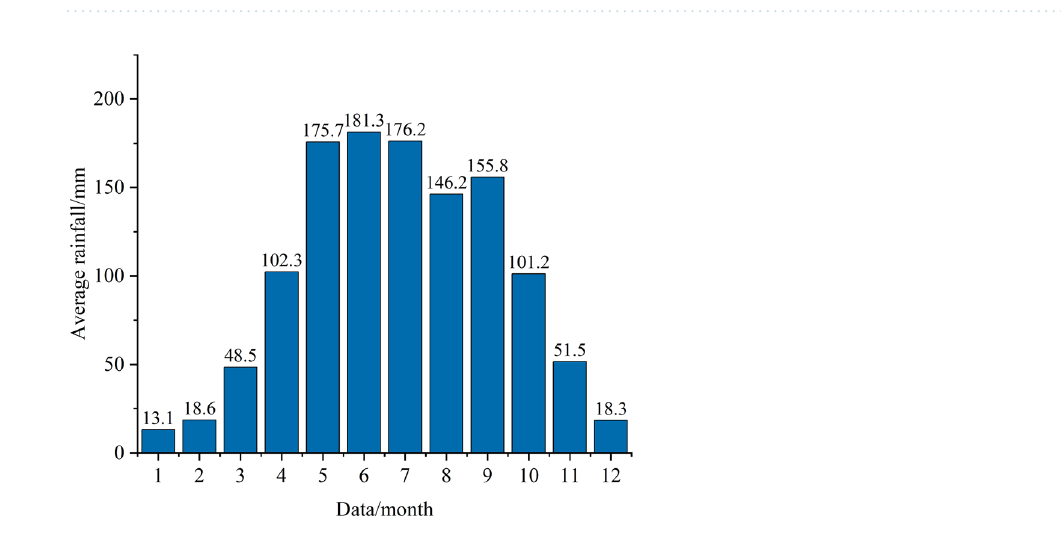
Figure 1. ( a ) Location of the study area; ( b ) location of Sifangbei landslide; ( c ) topographical map of the Sifangbei landslide, with the location of the monitoring network.